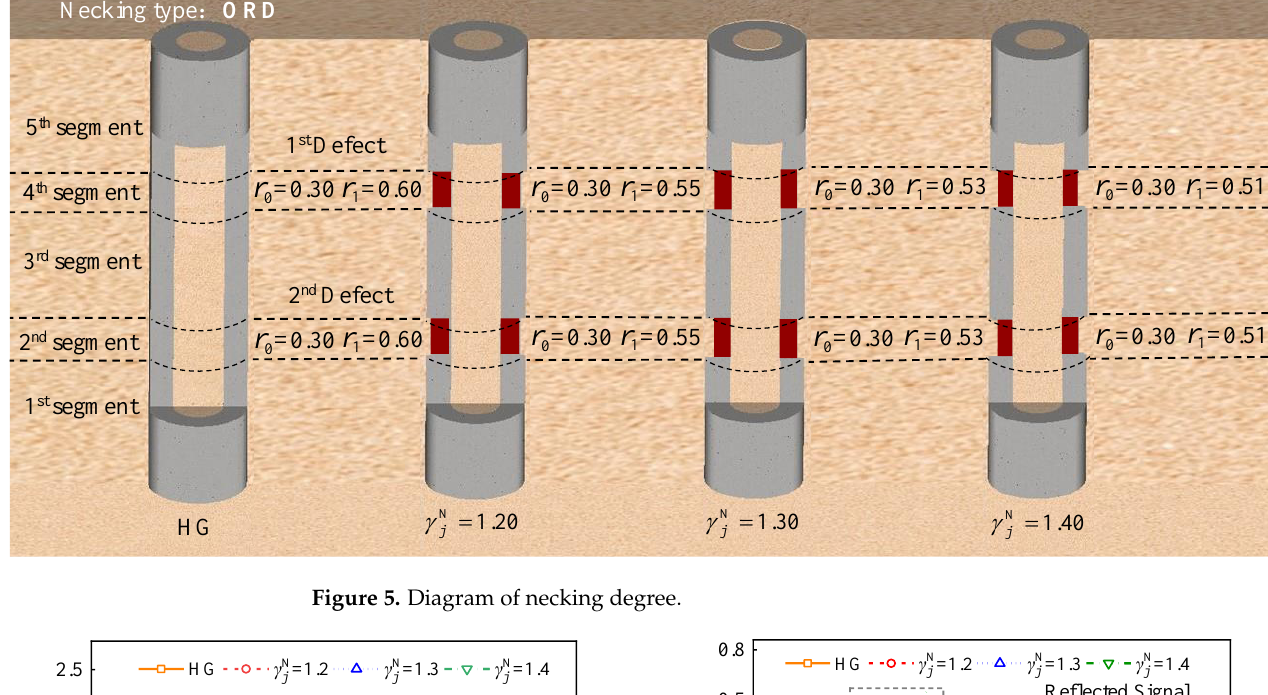
Figure 6. Effect of necking degree on the pipe pile response. ( a ) H